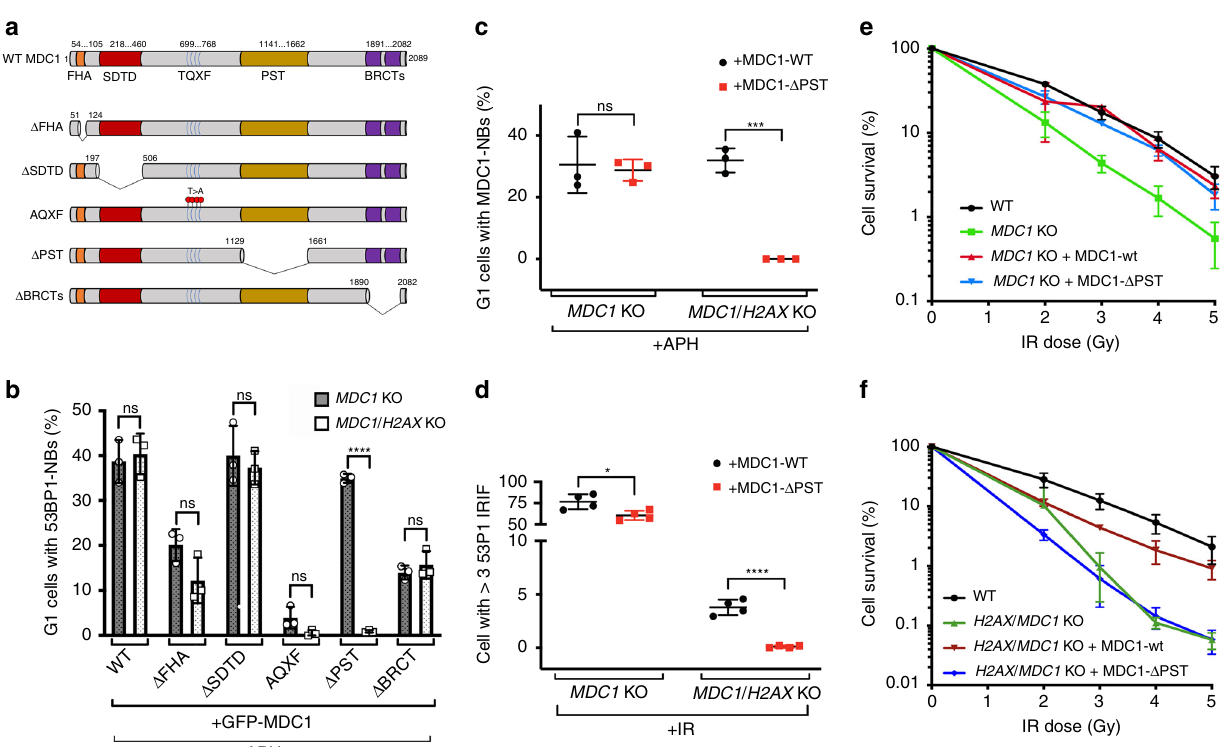
Fig. 3 The PST region of MDC1 mediates key DDR functions in cells lacking H2AX. a Schematic representation of MDC1 architecture and the different mutant versions used in this work. b Quanti fi cation of 53BP1-NB formation after 24 h of 0.4 μ M APH treatment in RPE-1 MDC1 − / – H2AX + / + and MDC1 − / − H2AX − / − cells complemented with indicated mutant versions of GFP-tagged MDC1; n = 3/genotype; error bars s.e.m.; **** p < 0.0001; two-tailed Student ’ s t test. c Quanti fi cation of MDC1-NB formation after APH treatment (as in b ) of RPE-1 MDC1 − / − H2AX + / + and MDC1 − / − H2AX − / − cells complemented either with the WT or Δ PST versions of GFP-MDC1; n = 3/genotype; error bars s.e.m.; *** p < 0.001; two-tailed Student ’ s t test. d Quanti fi cation of 53BP1 IRIF 1 h after IR (3 Gy) treatment of RPE-1 MDC1 − / − H2AX + / + and MDC1 − / − H2AX − / − cells complemented with WT or Δ PST versions of GFP-MDC1; n = 4/genotype; error bars s.e.m.; **** p < 0.0001, * p < 0.05; two-tailed Student ’ s t test . e Clonogenic survivals after IR